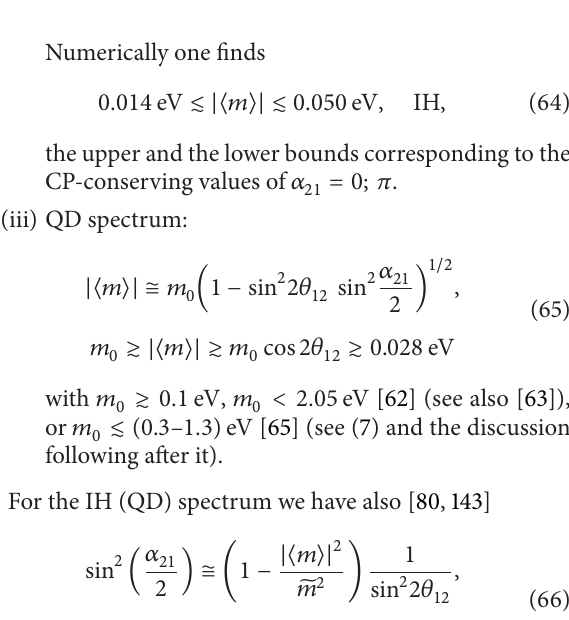
Figure 1: The effective Majorana mass |⟨𝑚⟩| (including a 2 𝜎 uncertainty), as a function of min (𝑚 𝑗 ) for sin 2 𝜃 13 = 0.0236 ± 0.0042 [27, 28] and 𝛿 = 0 . The figure is obtained using also the best fit values and1 𝜎 errorsof Δ𝑚 2 21 ,sin 2 𝜃 12 ,and |Δ𝑚 2 31(32) | giveninTable1.7in[11]. The phases 𝛼 21,31 are varied in the interval [0,𝜋] . The predictions for the NH, IH, and QD spectra are indicated. The red regions correspond to at least one of the phases 𝛼 21,31 and (𝛼 31 − 𝛼 21 ) having a CP violating value, while the blue and green areas correspond to 𝛼 21,31 possessing CP conserving values (from